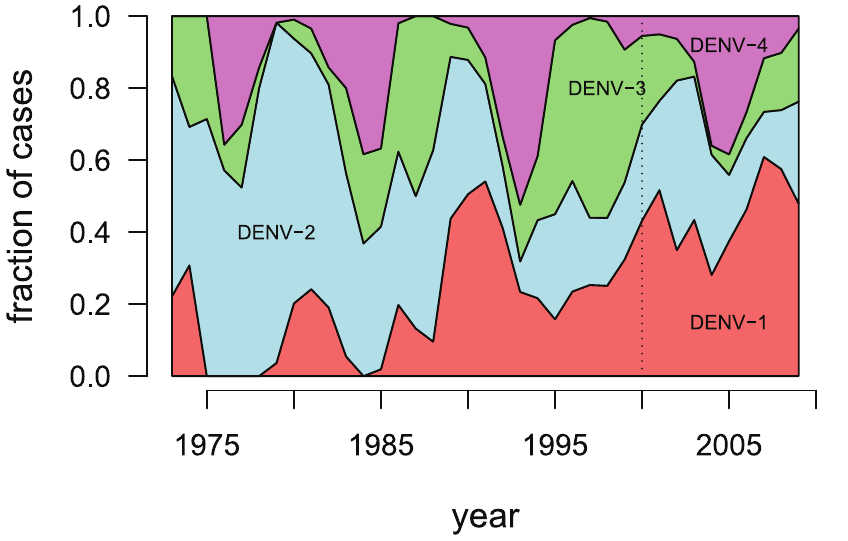
Figure 2. Estimated relative prevalence of the 4 serotypes in Thailand. The data are from two sources: Thailand’s Health Ministry from 2000– 2009 (available at http://epid.moph.go.th) and the Queen Sirikit National Institute of Child Health in Bangkok from 1973–1999 [31]. The vertical dotted line indicates the point of transition between the two datasets. Simulated prior immunity to each of the four dengue serotypes for individuals in the model were based on their ages and these data.